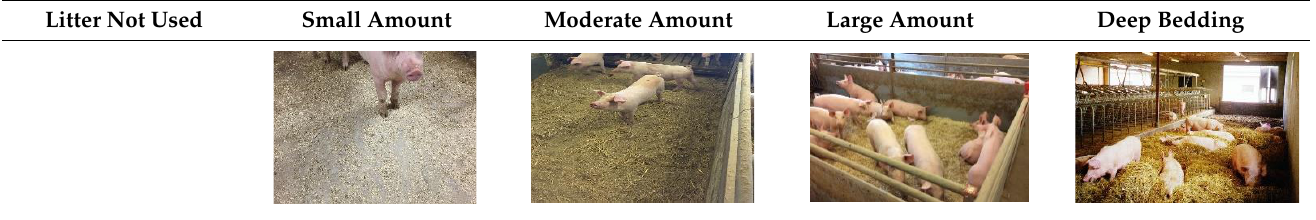
Table 1. Amount of the litter on the solid floor.